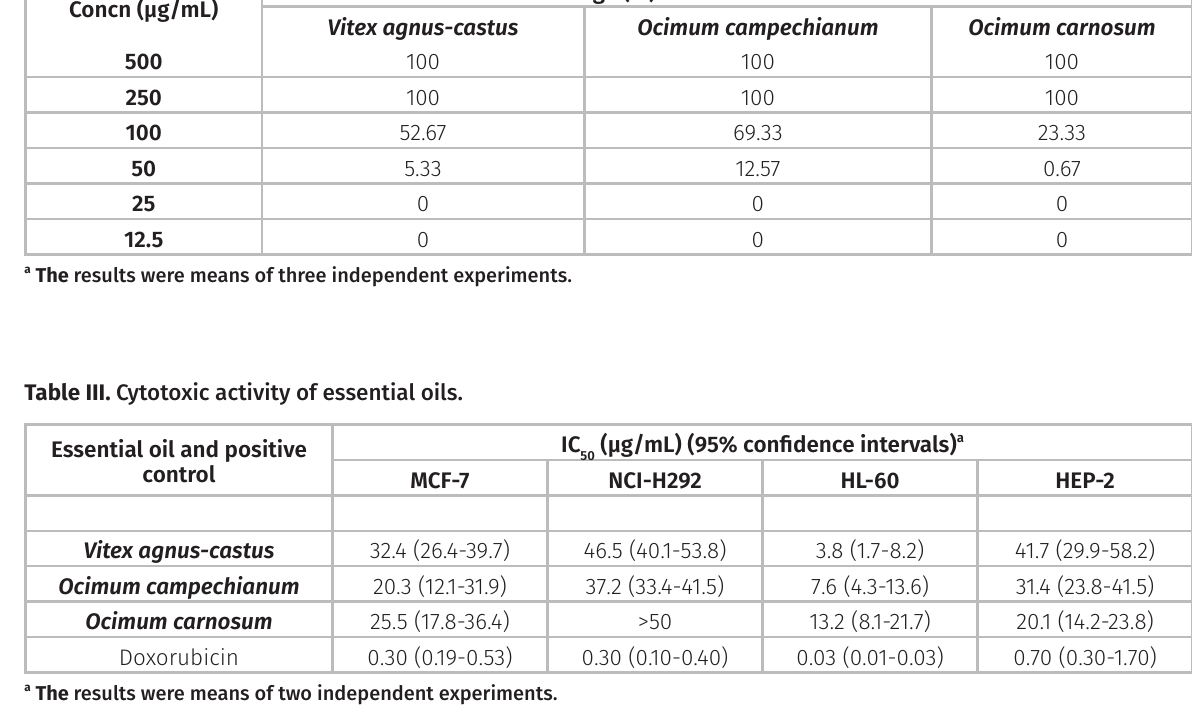
Table II. Larval mortality (%) of essential oils against third-instar of Aedes aegypti larvae. Concn (μg/mL)